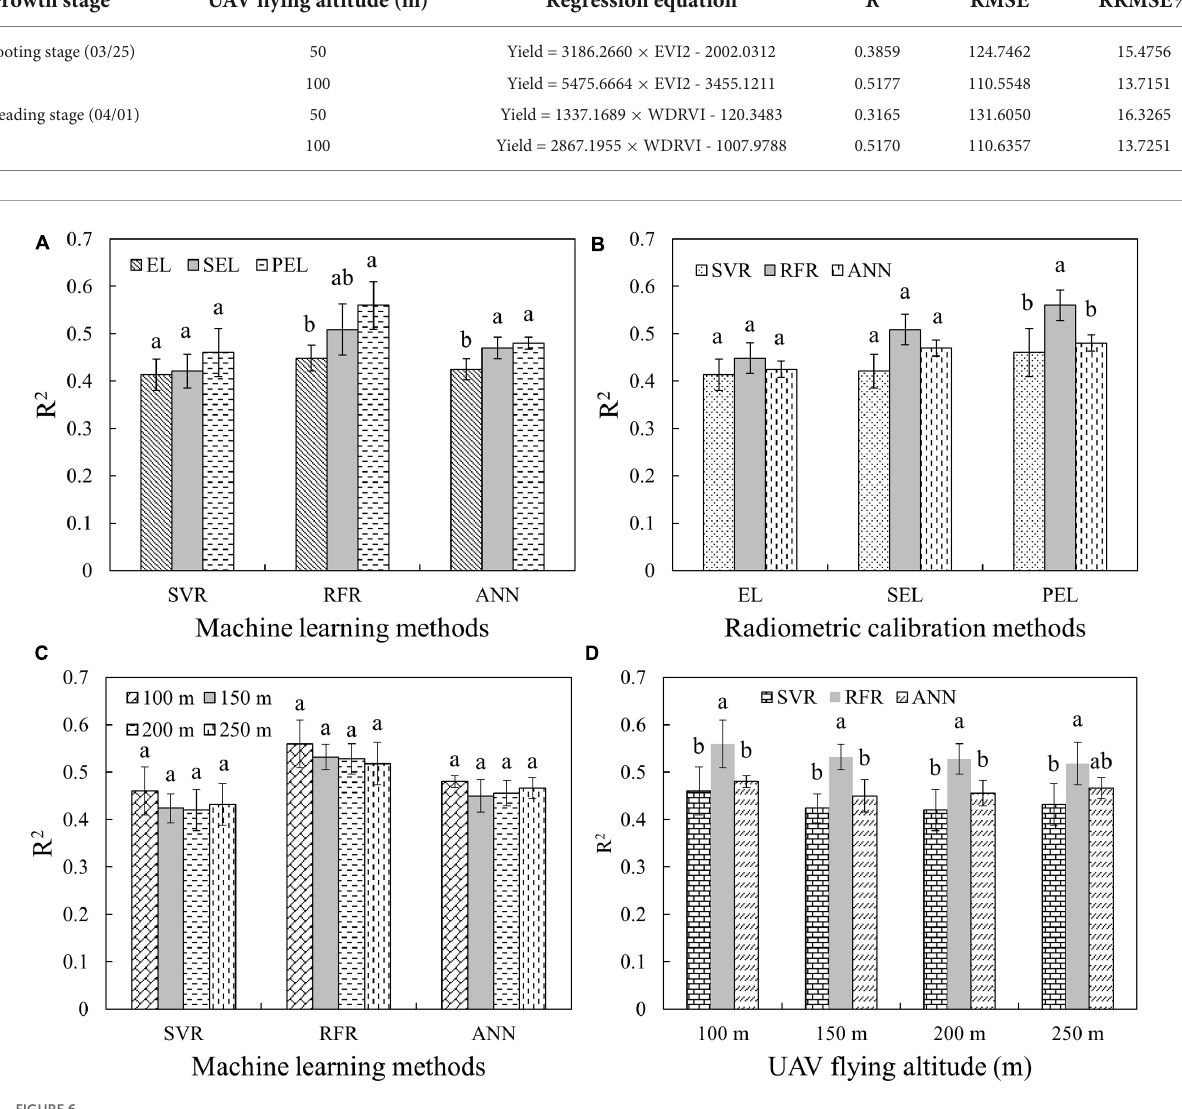
FIGURE6 R 2 -values of multi-stage rice yield prediction using machine learning methods with different RCMs or UAV-FAs: (A) Comparison of different RCMs and same machine learning methods using CI green ; (B) comparison of same RCMs and different machine learning methods using CI green ; (C) comparison of different RCMs and same UAV-FAs using NDVI; and (D) comparison of same UAV-FAs and different machine learning methods using